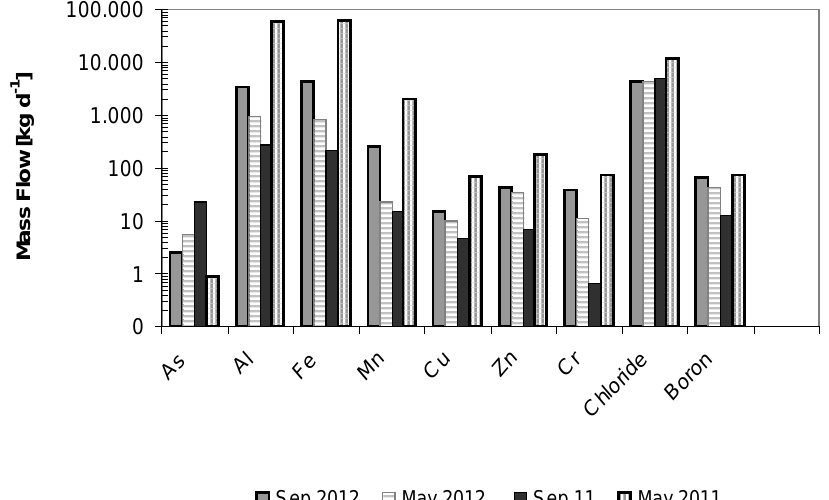
Figure 5. Concentrations of arsenic (µg·L −1 ) in a longitudinal profile from the Khentii Mountains. (Sugnugr Gol, natural reference conditions) to the river basin outlet at Buren Tolgoi based on four “snapshot” sampling campaigns of surface water in May and September 2011 and 2012 (21 May 2011, 06 September 2011, 18 May 2012, 9 September 2012). The allocation of sampling sites is indicated by the code number of the individual water bodies (Table 5, Figure 3). In comparison, the acceptable maximum content of arsenic according to the Mongolian drinking water quality standards (MNS (Mongolian National Standards) 900:2005) [69] is given as a horizontal line (Monitoring data of MoMo project).